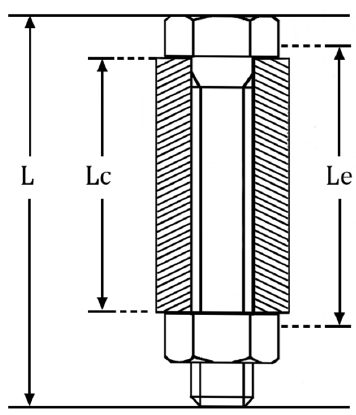
Figure 1. Bolt joint structure.